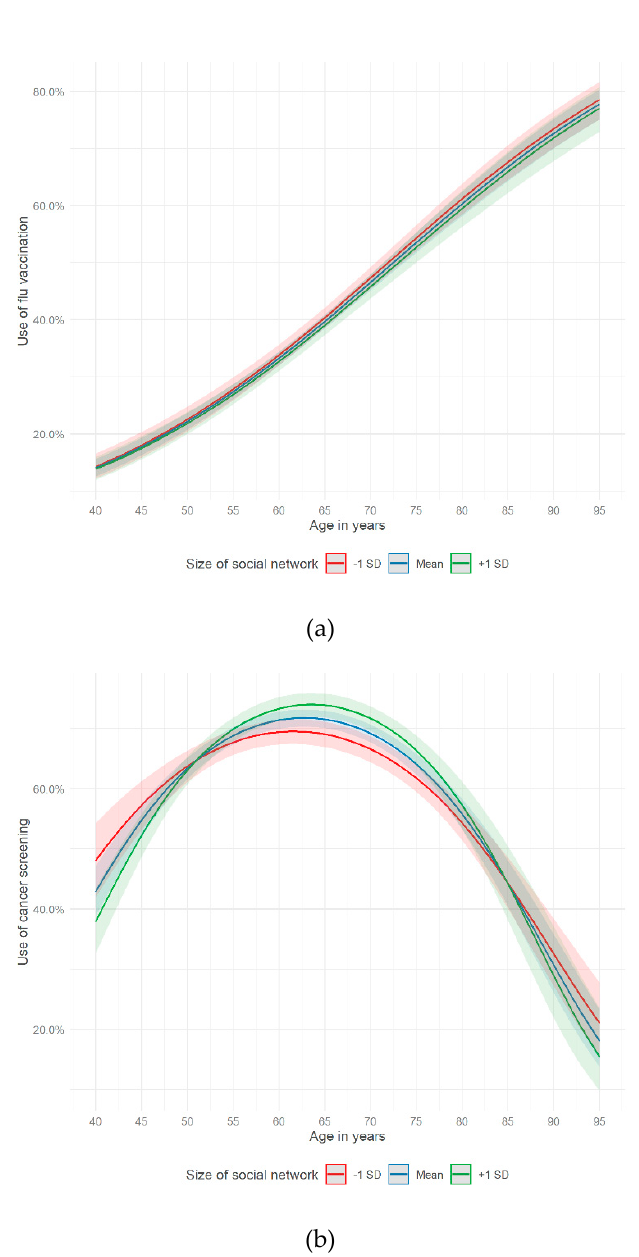
Figure 3. Use of ( a ) flu vaccination (Model 1.3) and ( b ) cancer screening (Model 2.3) on age and social network size (German Ageing Survey, 2014).